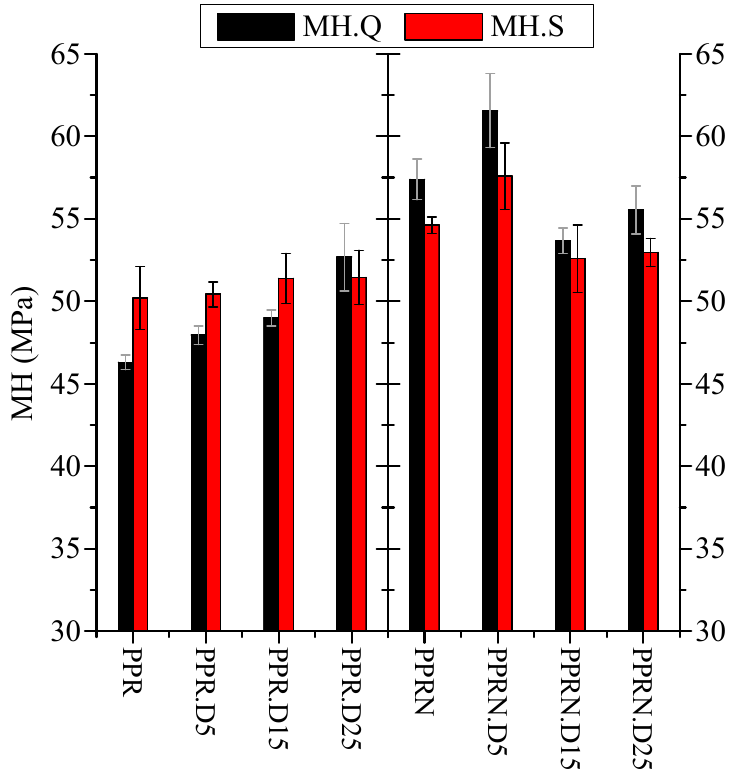
Figure 10. MH values for the different samples under the Q and S processing conditions.